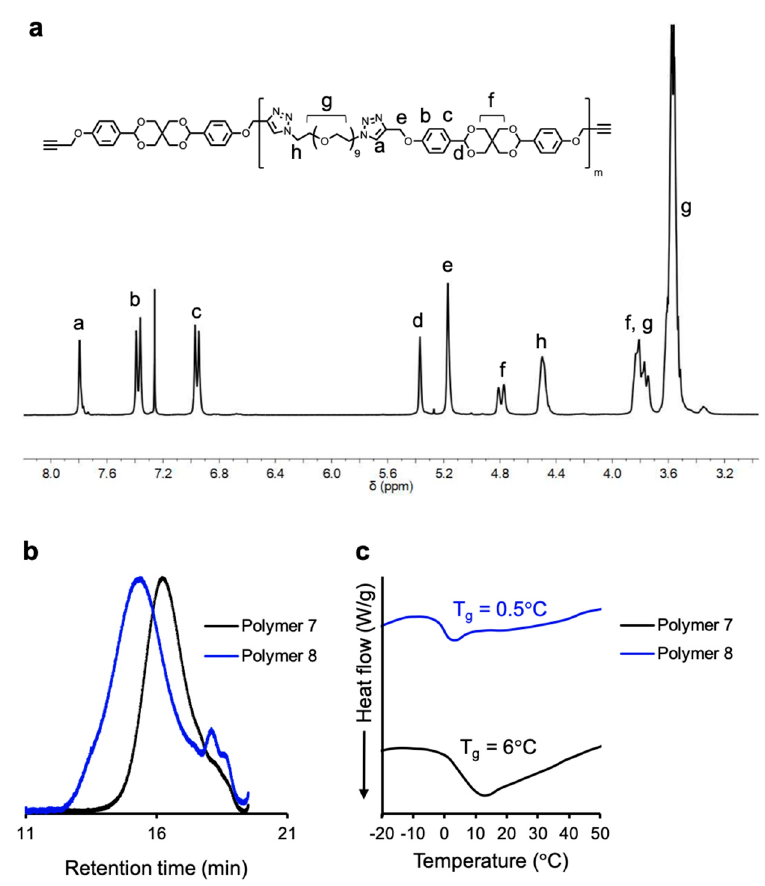
Figure 1. ( a ) 1 H NMR of 7 ; ( b ) refractive index (RI) traces in the SEC analysis of 7 and 8 in DMF; ( c ) DSC analysis of 7 and 8 showing amorphous spirocyclic polyacetals at room temperature. Before particle formation and pH-triggered degradation and model drug release ex-